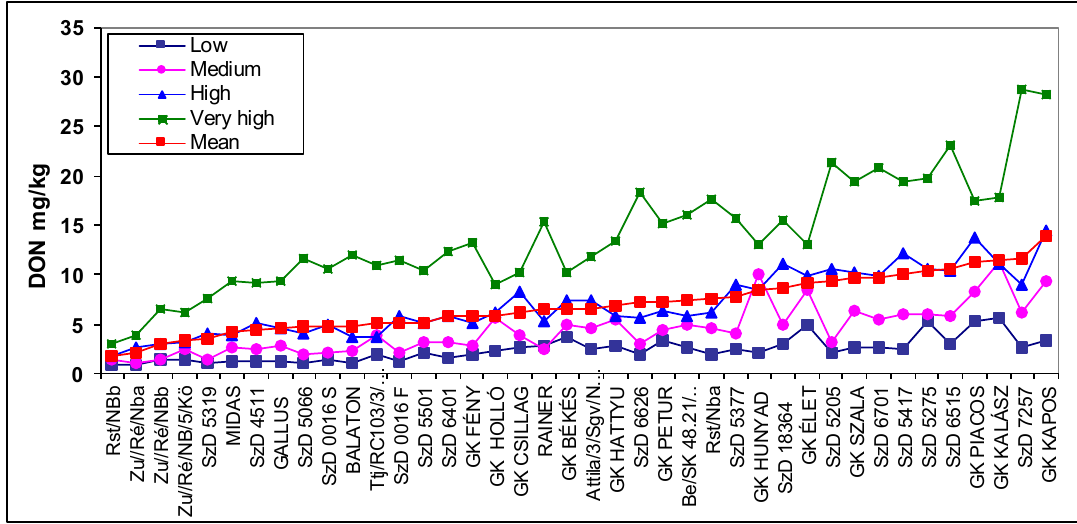
Figure 5. Deoxynivalenol (DON) data (mg / kg) in the methodical test for inoculation methods across years and methods according to aggressiveness level, 2009–2012 [26] LSD 5% for genotypes: 2.14, between any points in the chart (except genotype means) 4.28.